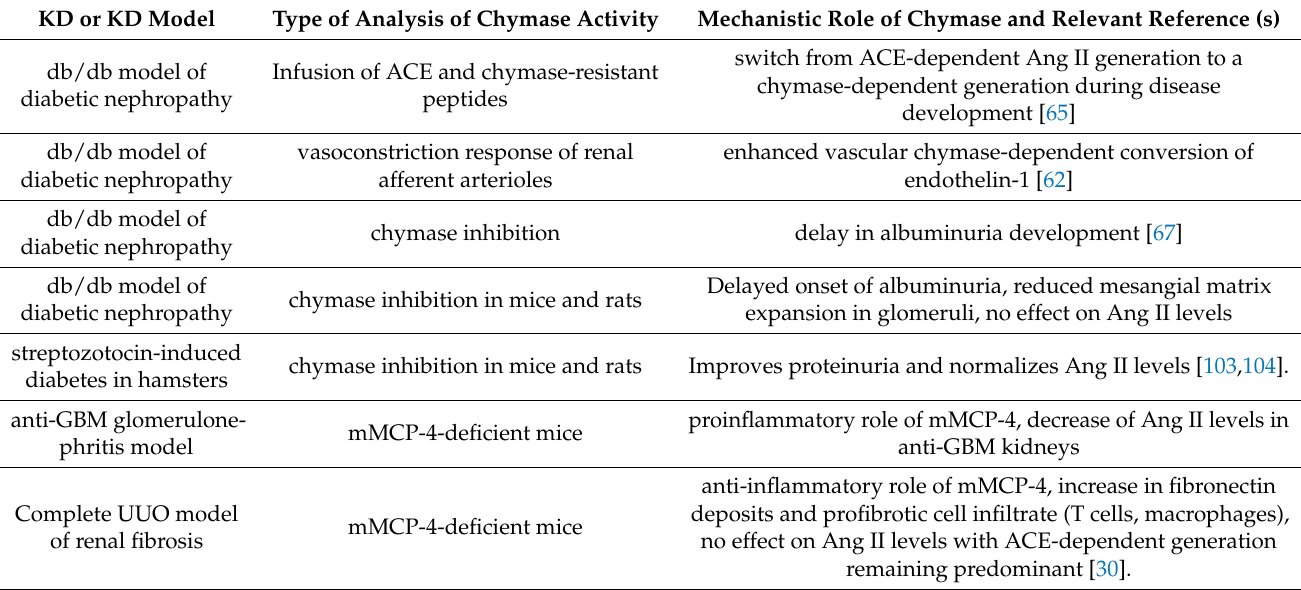
Table 1. Summary of the role of chymase in kidney